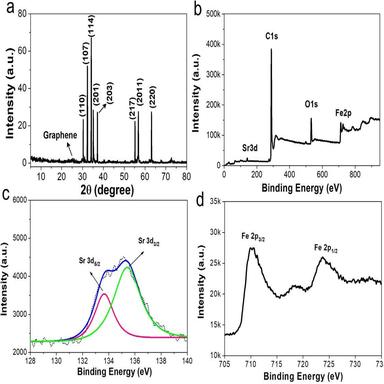
(a) XRD pattern, and XPS spectra (b) survey scan, (c) high resolution Sr 3d and (d) high resolution Fe 2p of SrFe12O19 NR/G-29.7.